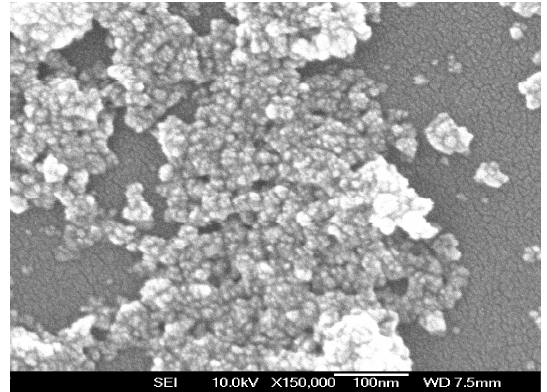
Figure 2. FE-SEM photograph of the as-prepared powder.